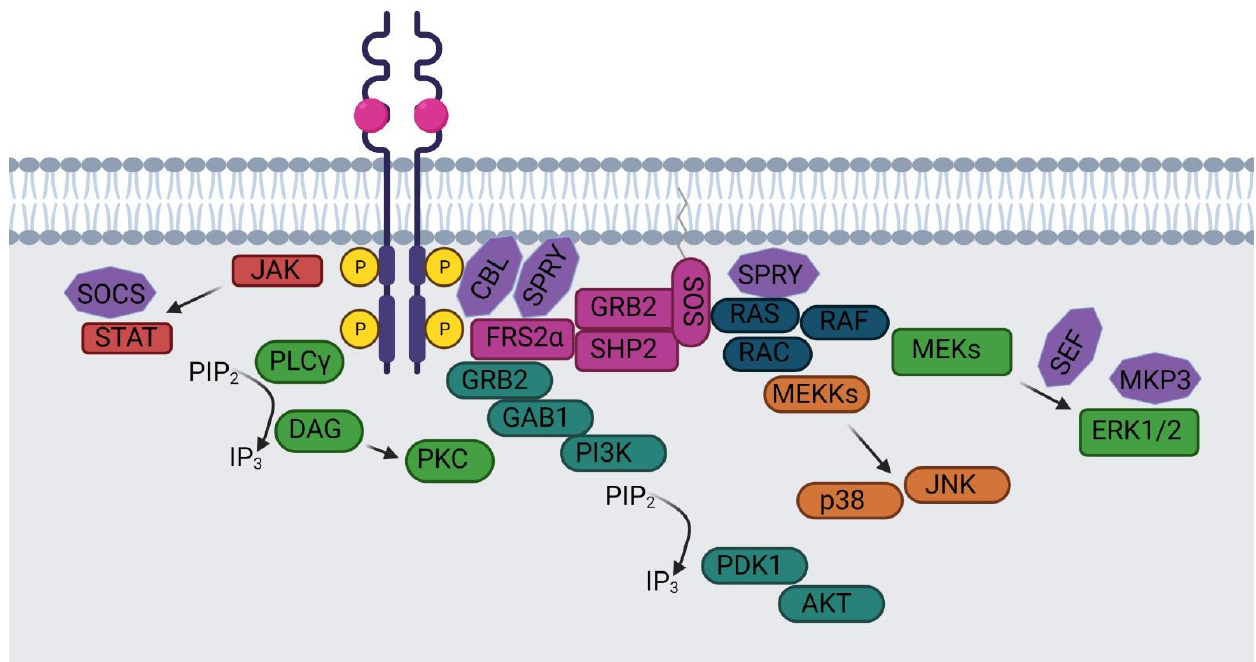
Figure 2. FGFR signaling cascade and inhibitory molecules. FGF receptor modulates several pathways in the cell through the action of many molecules. Inhibitors of FGFR signaling cascade can act on different levels and on several steps of this process. Molecules indicated by a violet star represent the proteins able to negatively regulate the activity of the FGFR.